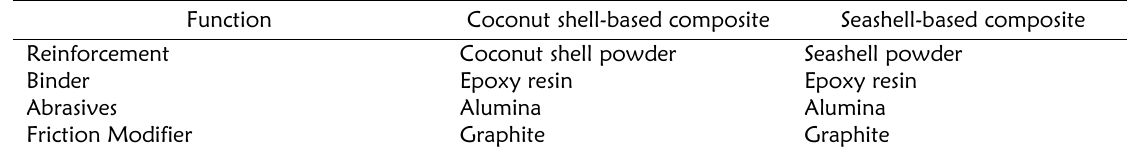
Table 3: Materials used for production of composites